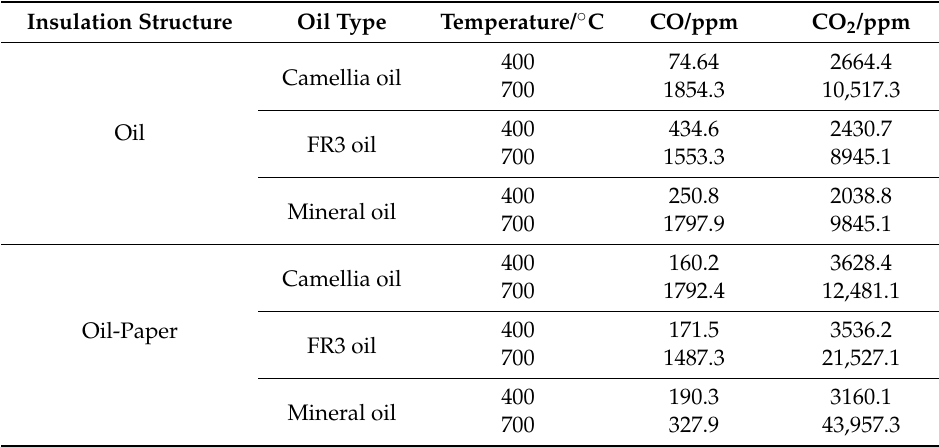
Table 5. CO and CO 2 content in oil under thermal faults above 300 °C.